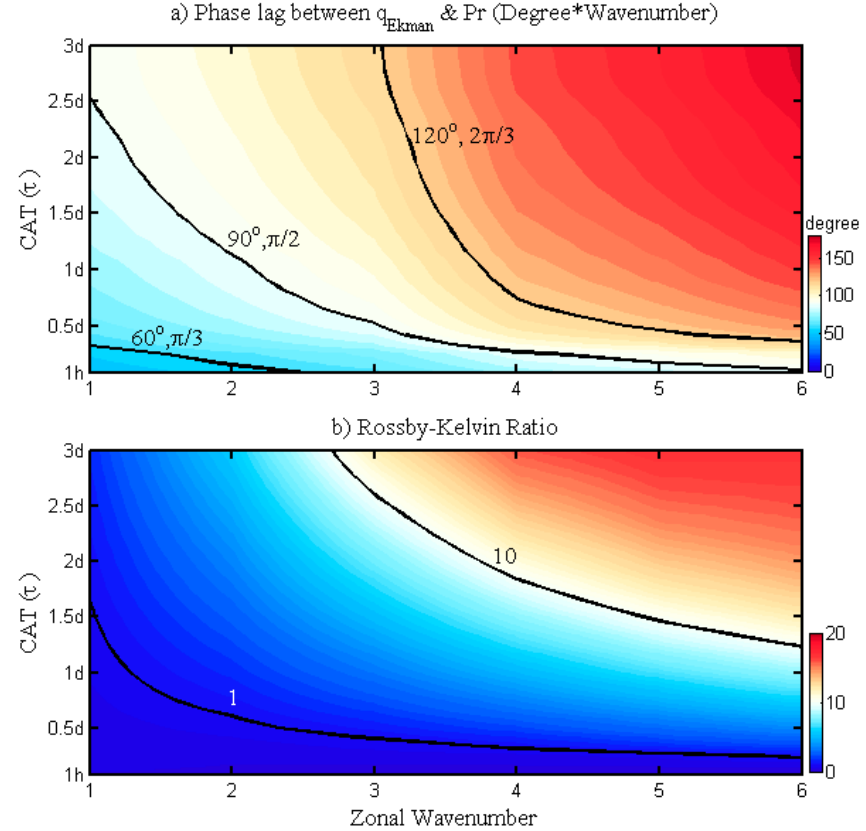
Figure 4. Phase lag and Rossby–Kelvin ratio associated with different values of spatially uniform CAT: ( a ) phase lag between upward PBL Ekman pumping and precipitation on the equator; and ( b ) Rossby–Kelvin ratio as a function of wavenumber and spatially uniform CAT in the FCDM model. Phase lag for all waves is compared in a range of 360 degrees by multiplying the wavenumber. The Rossby–Kelvin ratio is defined by the ratio of the maximum pressure anomalies between the off-equatorial (15°–20° N) and equatorial (5° S–5° N) regions.